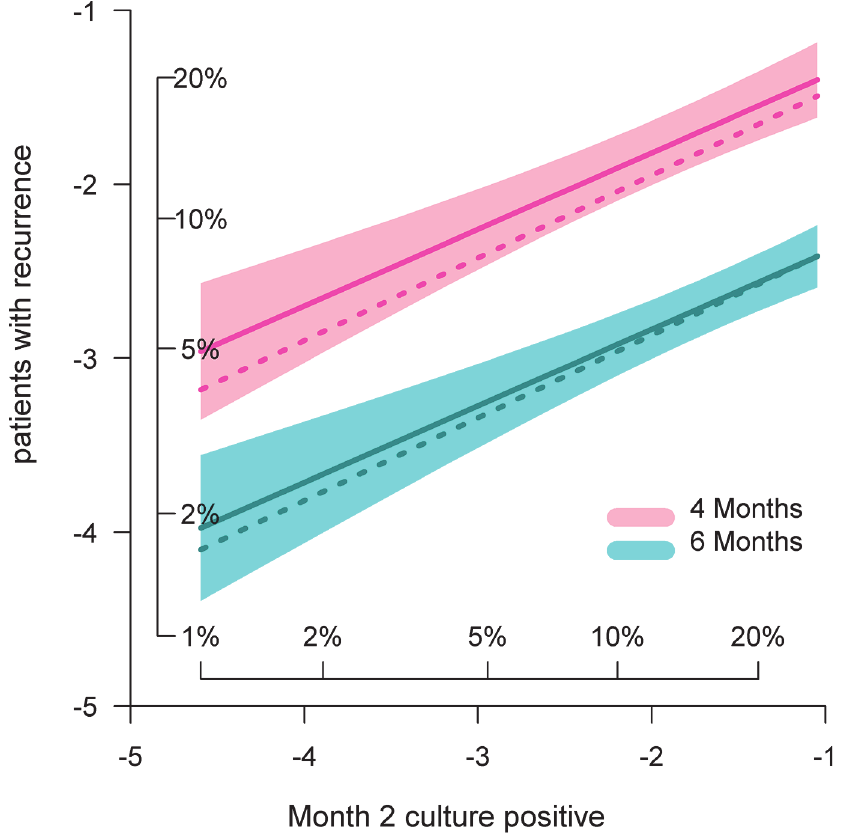
Fig 2. Predicted proportion of patients with recurrence based on the proportion positive after 2 months of treatment, for regimens of 4 and 6 months duration. Axes indicate logit-transformed proportions; inset scales indicate corresponding percentages. Solid and dotted lines indicate updated and original model predictions, respectively. Shading indicates 80% confidence intervals for the updated